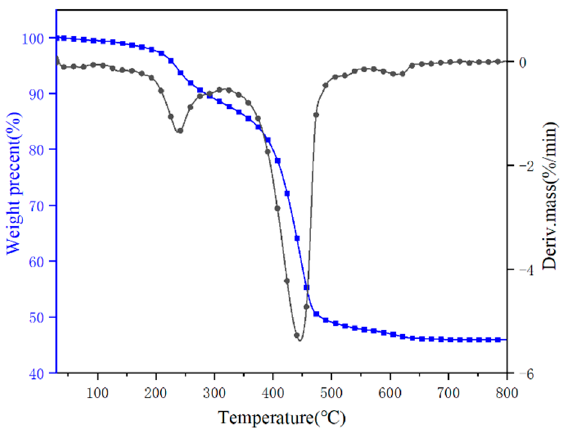
Figure 1. TG and DTG curves of hydromagnesite sample. Table 2. TG data of hydromagnesite sample under nitrogen.